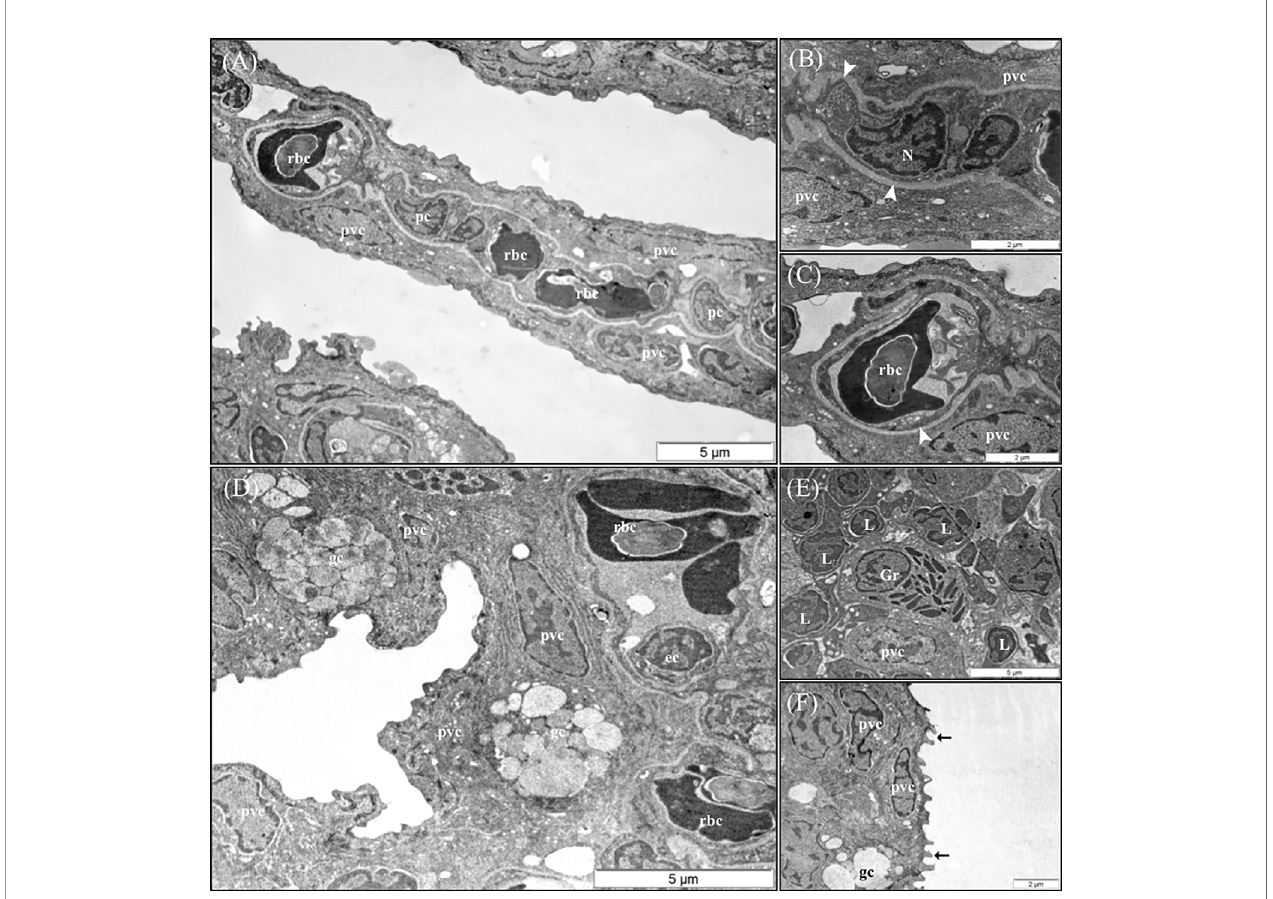
FIGURE 8 | Representative TEM micrographs of the gill of European sea bass ( Dicentrarchus labrax ) fed the different dietary treatments. No signi fi cant alterations on the structural pattern of healthy gills were observed among fi sh fed the different dietary treatments. (A) Cross-section through the secondary lamellae. Observe the polymorphic nucleus of pilar cells, the electron dense red blood cells within the blood spaces and pavement cells surrounding the collagen bundle. Scale bar 5 m m. Detailed micrograph pilar cell (B) and blood space (C) , observe the collagen bundle embracing both structures (arrowhead). Scale bars 2 m m. (D) Pattern of the space between two secondary lamellae, where goblet cells (gc) are located and surrounded by pavement cells. Epithelial cell visible inside the blood space. Scale bar 5 m m. (E) Detailed micrograph of interbranchial lymphoid tissue leucocytes population. Scale bar 5 m m. (F) Detail of pavement cells microridges. Scale bar 2 m m. pc, Pilar cells; rbc,red blood cells; pvc, pavement cells; gc, goblet cells; ec, ephitelial cell; Gr, granulocyte; L,